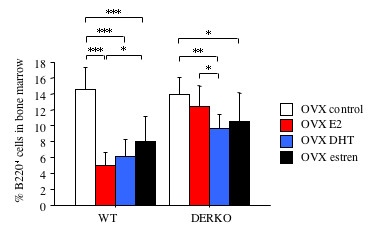
DHT and estren reduce the frequency of B220+ cells bone marrow independently of estrogen receptors. Ovariectomized 11-month-old female WT and DERKO mice were given daily s.c injections of E2 (0.7 μg/day), DHT (120 μg/day) or estren (75 μg/day) during four weeks. Control mice received olive oil. As expected, the E2 mediated reduction of B220+ cells in bone marrow of WT mice was lacking in DERKO mice. Treatment with DHT or estren resulted in a lower frequency of B220+ cells in bone marrow of both WT and DERKO mice. One-way ANOVA followed by Fisher's test was used to compare data from mice in different treatment groups. Results are presented as mean ± standard deviation. * P < 0.05, * *P < 0.01, *** P < 0.001.